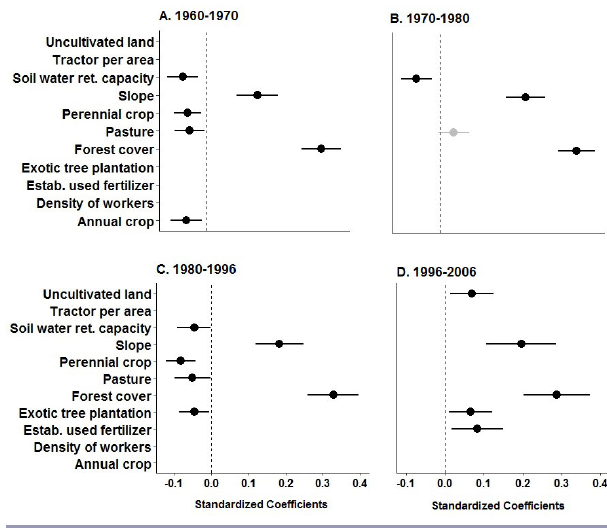
Fig. 4 . Mean parameters estimates (circles) and 2.5–97.5% confidence intervals (bars) for (A) 1960–1970, (B) 1970–1980, (C) 1980–1996, and (D) 1996–2006. Significance is based on CI values not overlapping zero. Significant effects are shown with filled black symbols and nonsignificant effects are shown with filled grey